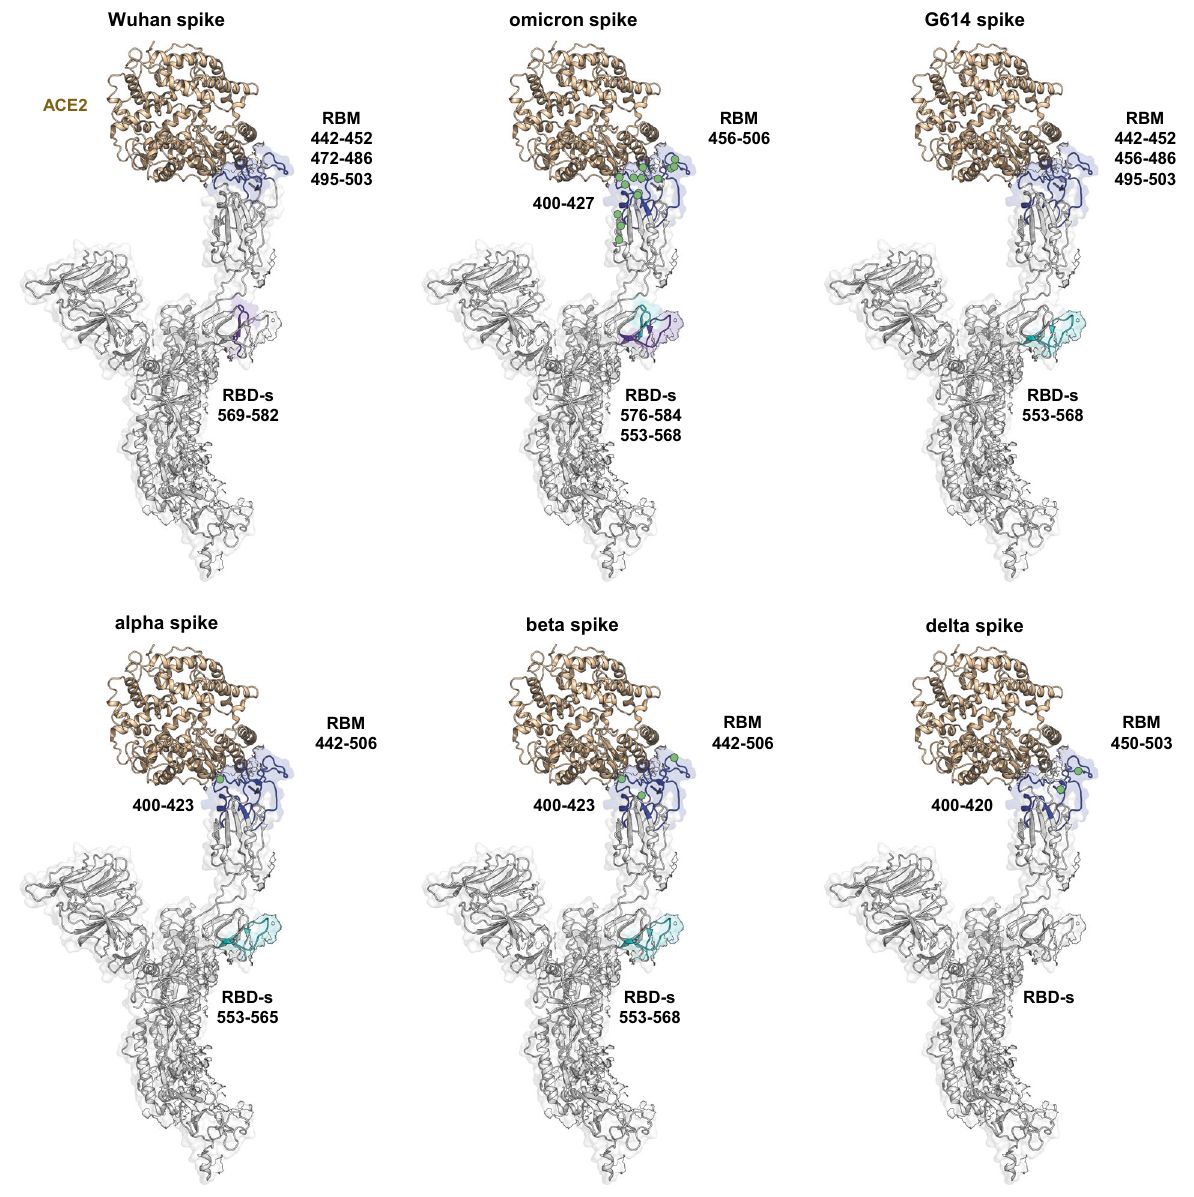
Fig. 4 | Effect of ACE2 binding on spikes dynamics. Regions manifesting decreased HDX in spikes when in complex with ACE2 are superimposed on one single protomer of spike D614 with one RBD bound (PDB: 7a95 14 ). In blue: